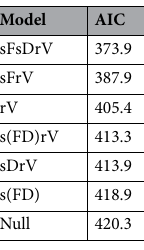
Table 1. Relative of models for total catch landed from a fishing trip. Model codes include F number of FADs visited, D length of trip in days, V vessel identity, null intercept only. Functional codes are s smooth term, r random effect term, parentheses indicate a multidimensional smooth across the included